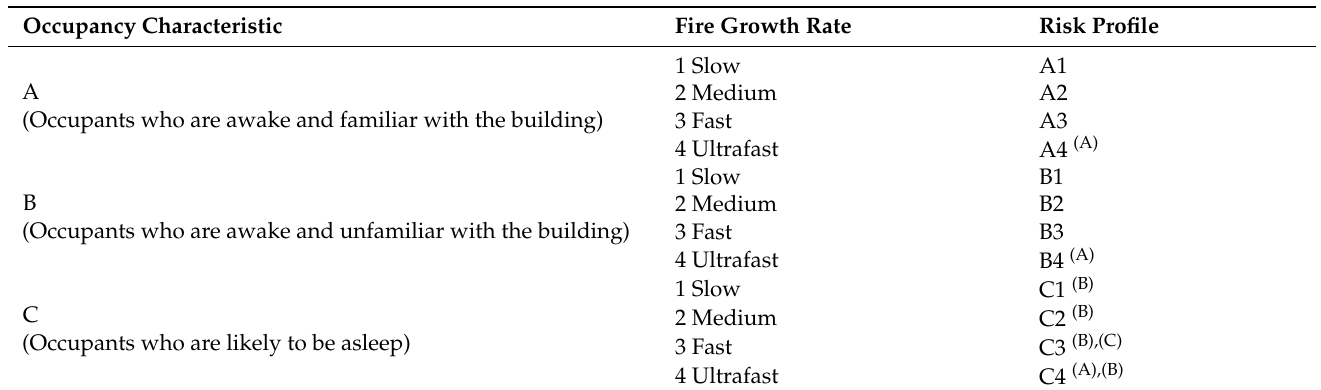
Figure 2. The fire strategy objectives matrix [1,18,40,41]. Table 1. Risk